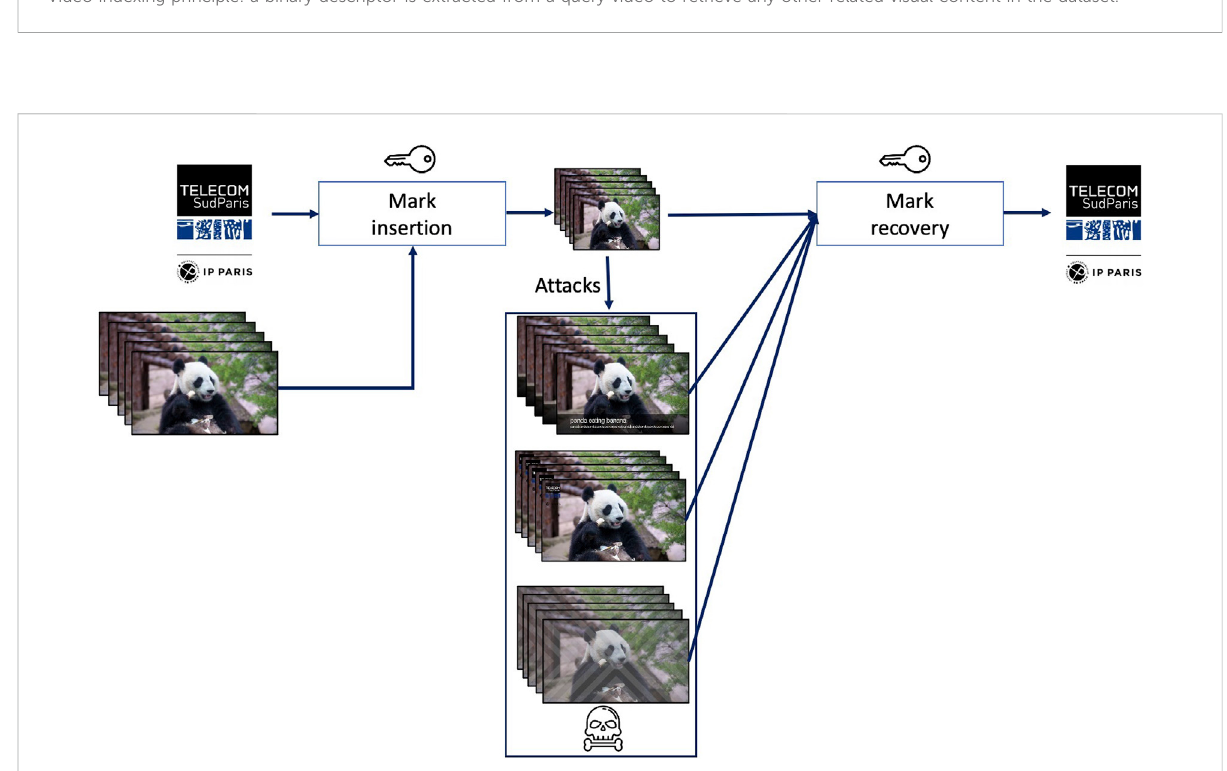
Frontiers in Signal